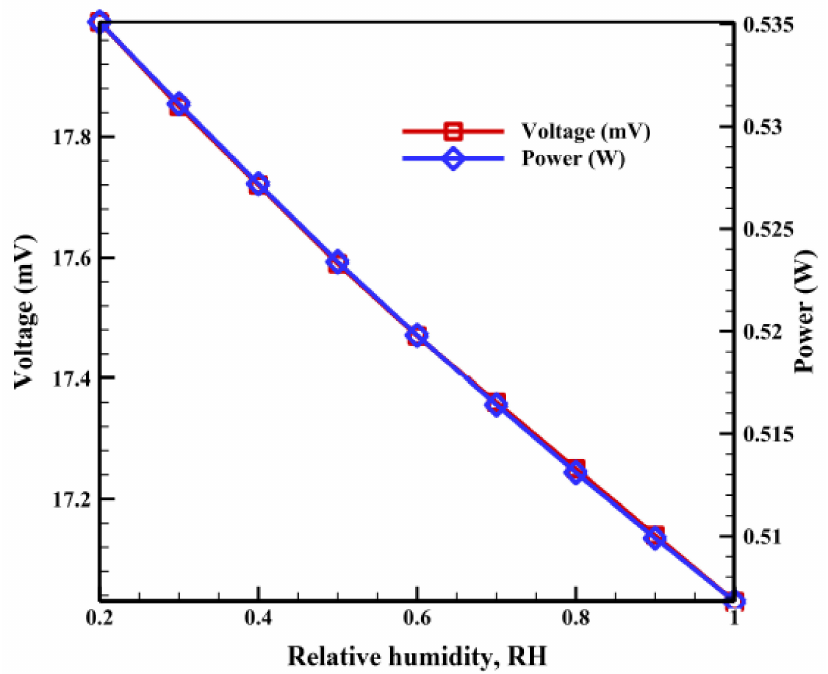
Figure 5. Effect of anodic relative humidity of PEMFC on the voltage and power of the pump (Reprinted with permission from Ref. [38], license No.